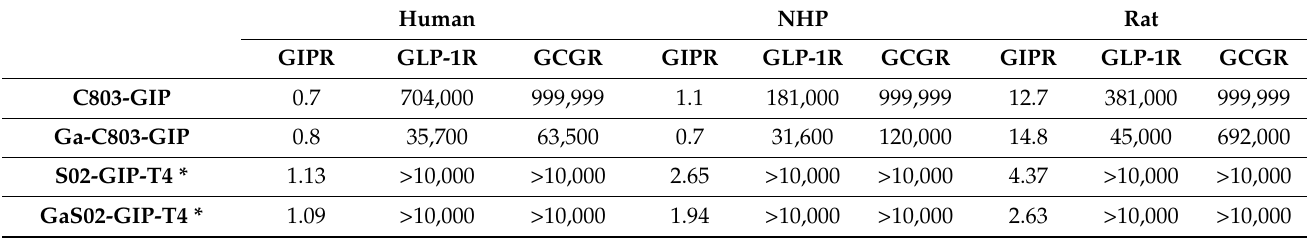
Table 2. The potency of the half-maximal effective concentration (EC 50 , [pM]) for C803-GIP, Ga-C803- GIP, S02-GIP-T4, and Ga-S02-GIP-T4 measured in HEK293 cells transfected with the GIPR, GLP1-R, and